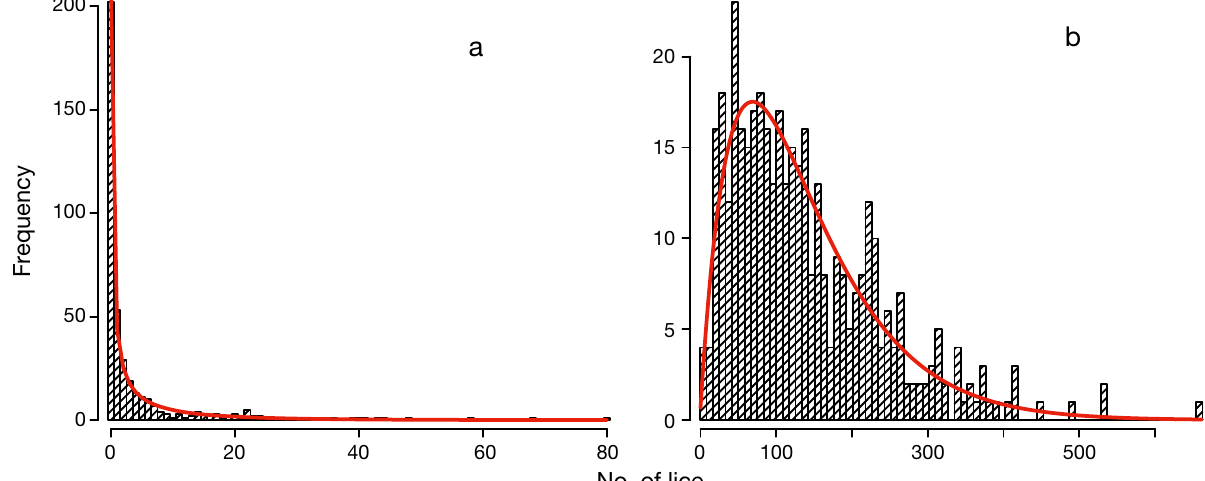
Fig. 1. Simulated salmon lice infestation distributions for a group of sea trout from (a) a low-infestation week and (b) a high- infestation week. Red lines: binomial distributions used to simulate the lice